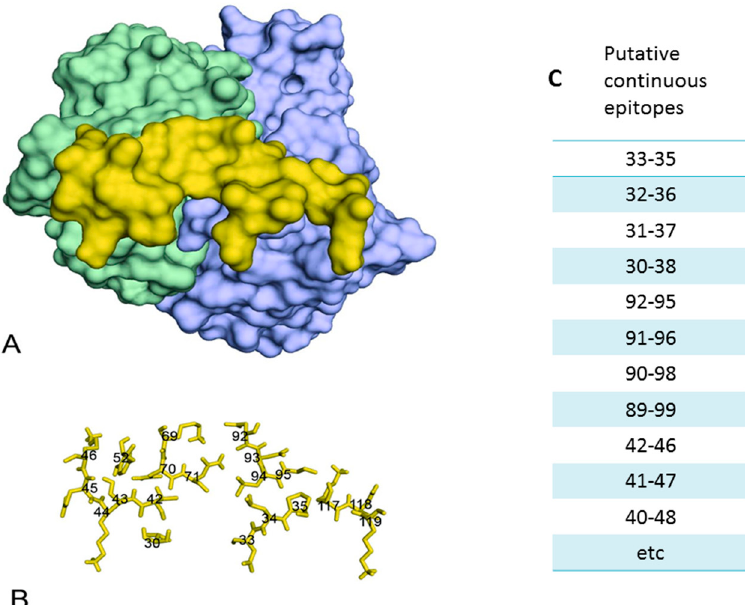
Figure 1. Discontinuous epitope of the outer surface protein A of the spirochete Borrelia burdorferi elucidated by X-ray crystallography from a complex with Mab 184.1. ( A ) Outline of the epitope in yellow; ( B ) position in space of the residues comprising the epitope. This set of residues cannot be isolated as such from the protein to demonstrate that it possesses binding activity in its own; ( C ) Parts of the discontinuous epitope and other peptide segments of the protein that may be able to bind Mab 184.1, in which case they would be called continuous epitopes (courtesy of Pernille Haste-Andersen, Danish Technical University).